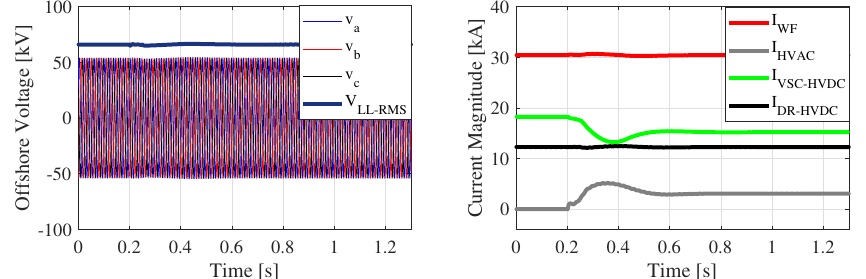
Figure 10. The voltage of offshore PCC ( left ) and currents ( right ) of OWF and transmission lines when the HVAC link re-connects.